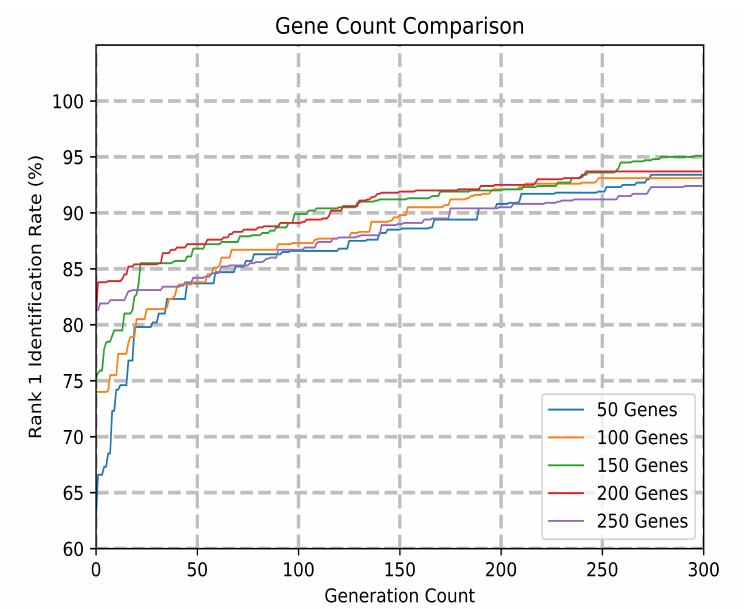
Figure 7. Comparison of model accuracy over 300 generations with various gene